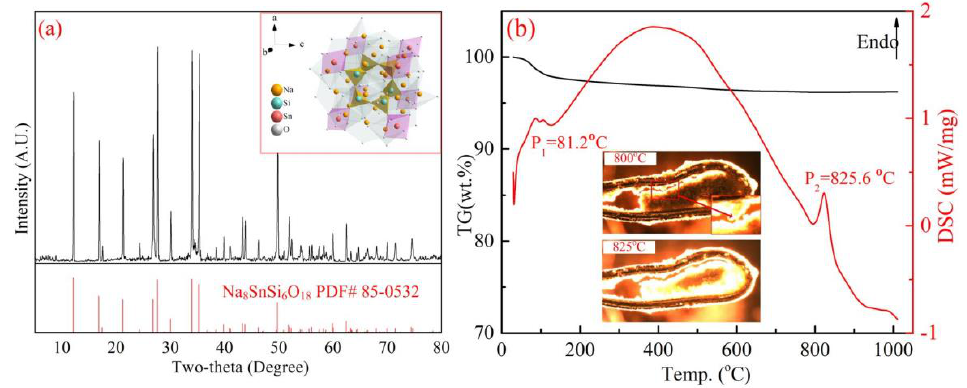
Figure 9. Properties of synthetic Na 8 SnSi 6 O 18 (( a )-XRD patterns, ( b )-TG-DSC analysis).